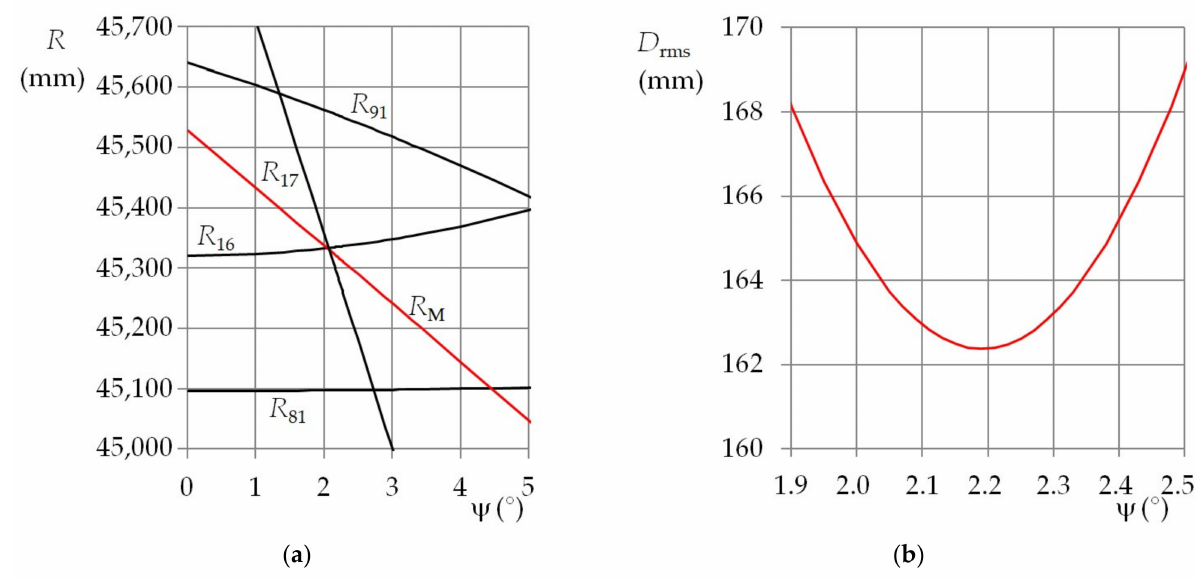
Figure 8. ( a ) Plots of the functional distances for diodes S 6 , S 7 , S 8 , and S 9 ; ( b ) root mean square of the distance deviations for diodes S 6 , S 7 , S 8 , and S 9 ; R 0 = 46,820 mm, f L = 120 mm, ω n = 20 ◦ , ψ n = 0 ◦